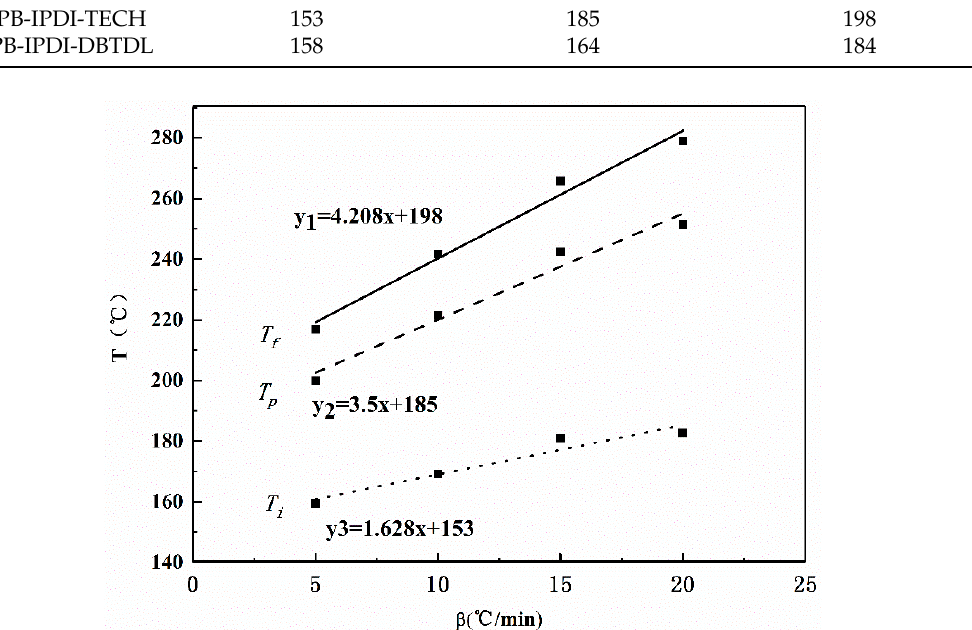
Figure 15. Extrapolation diagram of the curing reaction temperature at a zero heating rate for the EHTPB-IPDI-TECH system.